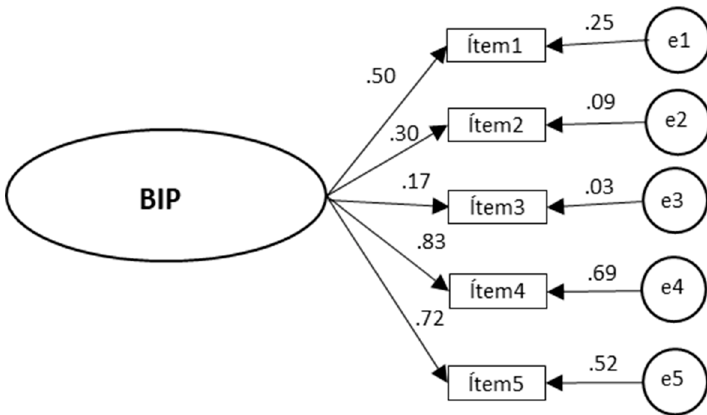
Figure 2. Confirmatory factor analysis of the BIP-Q5 model for COVID-19.